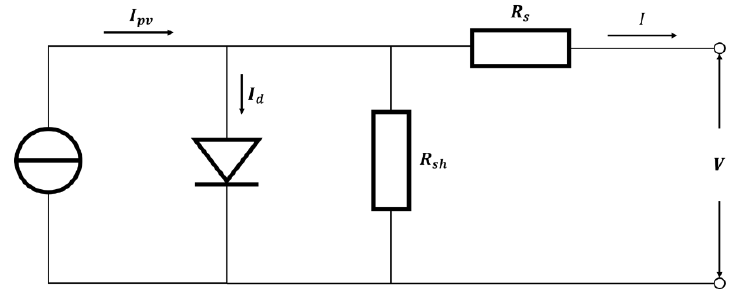
Figure 3. One diode model.